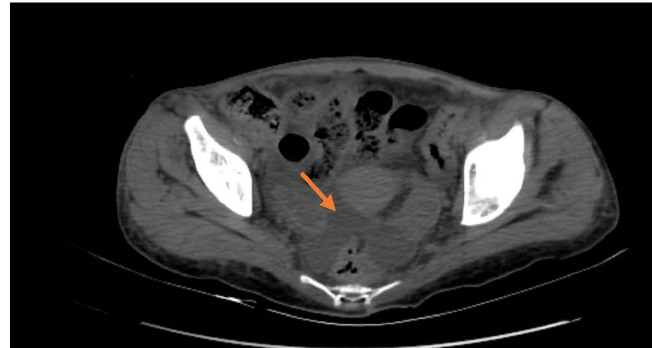
Figure 1. Moderate ascites (arrow).